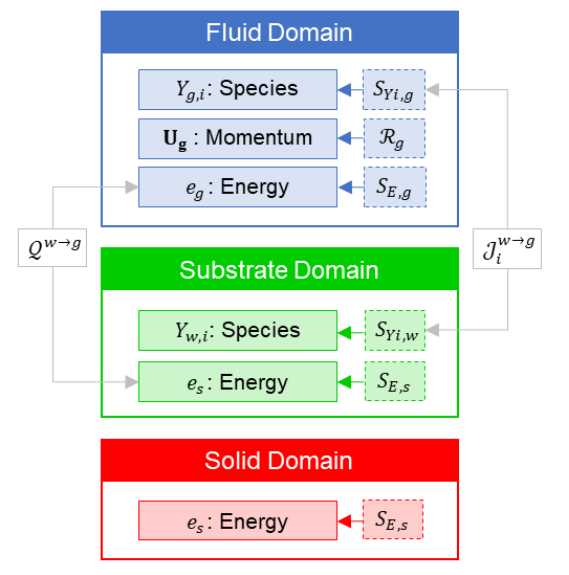
Figure 1. Simulation framework: multi-region